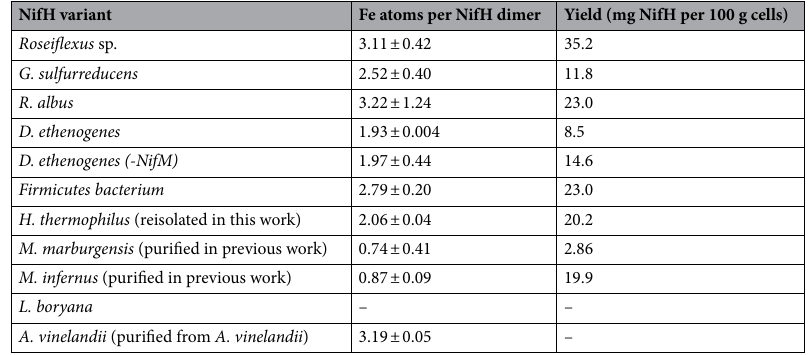
Table 1. Iron content per NifH dimer and purification yield for all soluble NifH variants purified from yeast. Iron content shows mean and standard deviation (n = 2 technical replicates).